Question: Produce a descriptive caption suitable for publication.
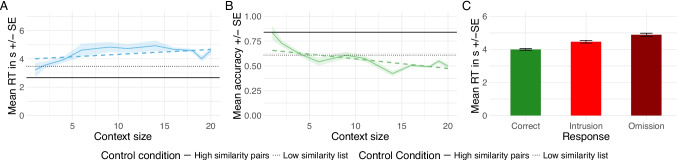
Answer: Results Experiment 3. A The effect of semantic context on RTs. The two black lines show the mean RTs of the two control conditions. B The effect of semantic context on accuracy. The two black lines show the mean accuracy of the two control conditions. C The mean RT for the different response types. All shaded areas around the mean and the error bars represent the standard error (SE) of the mean